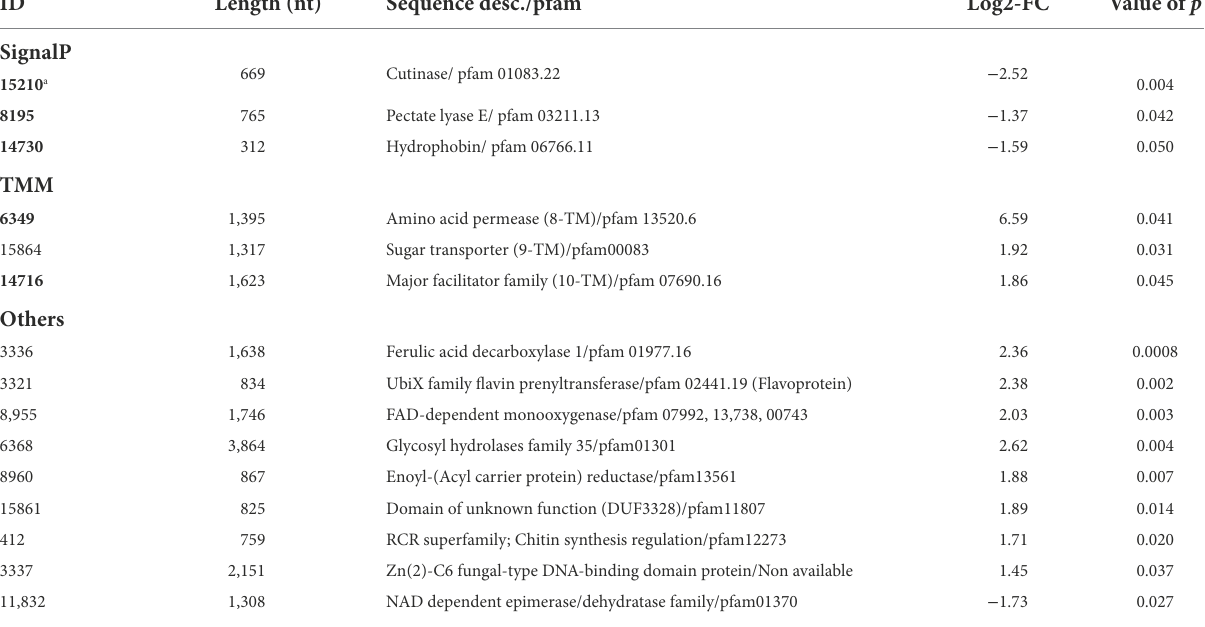
TABLE 3 List of DEGs ( p < 0.05) under 1 μ M ethephon